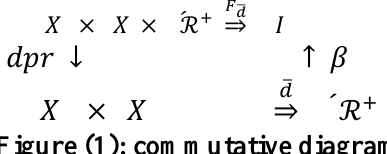
Figure (1): commutative